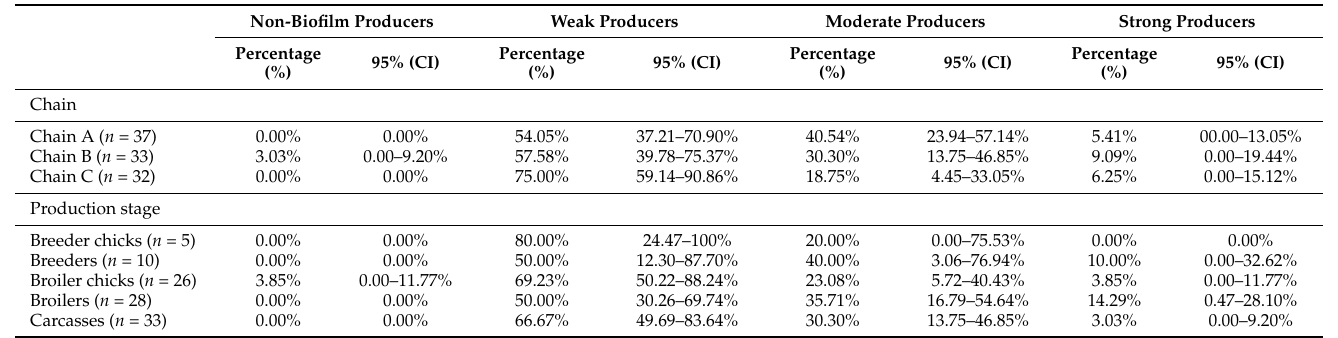
Table 1. Ability to form biofilms by ESBL/pAmpC-EC according to production chain and production stage.